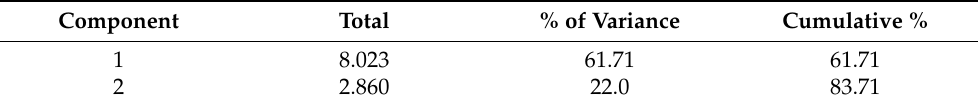
Table 6. Total variance of otolith descriptors based on component grouping of D. kurroides from Sulu and Sibuyan